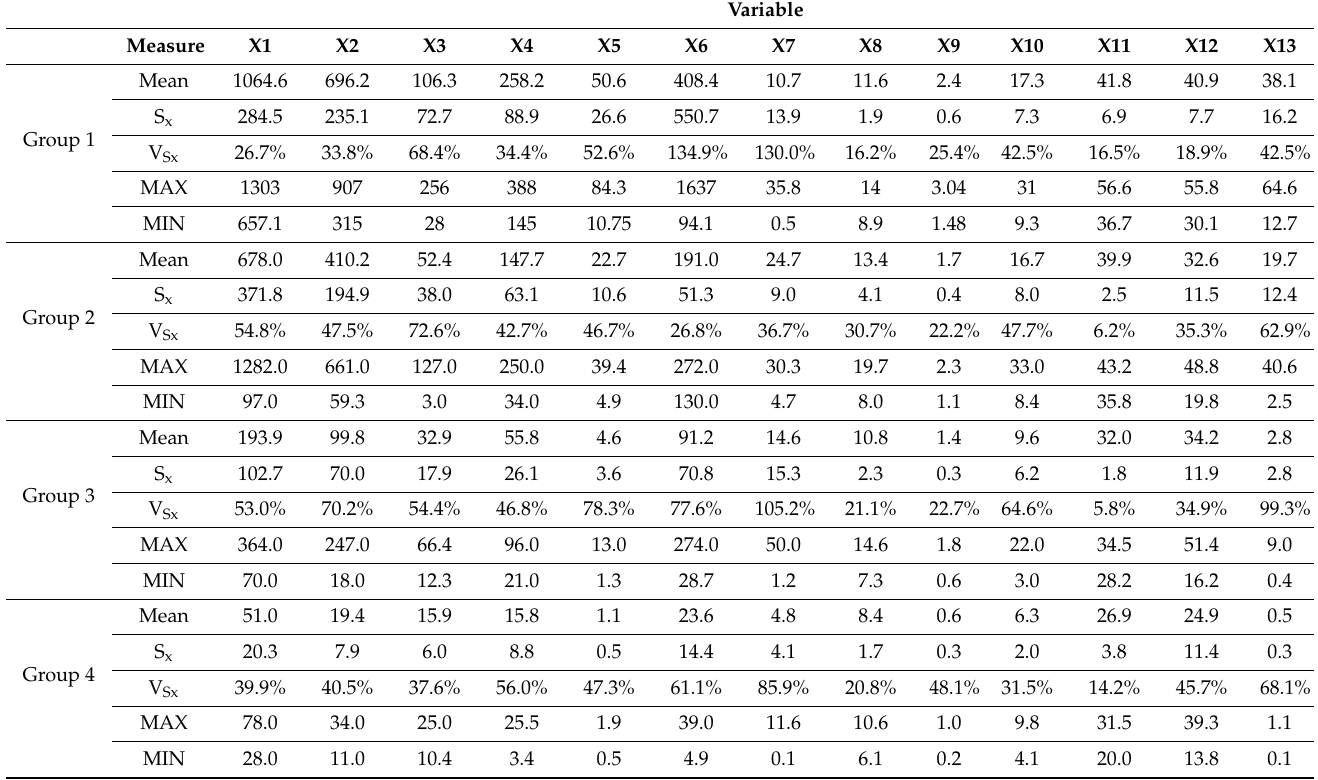
Table 6. Comparison of selected measures of descriptive statistics for individual groups in